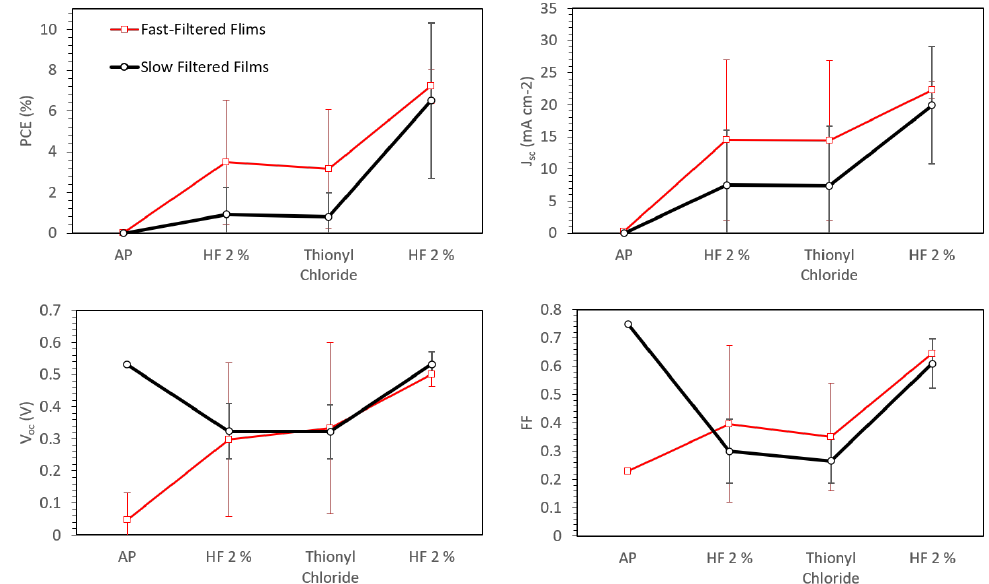
Figure 6. J / V properties for devices with 400 µ L aliquot slow and fast-filtered arc-discharge SWCNT Figure 6. J/V properties for devices with 400 µL aliquot slow and fast-filtered arc-discharge SWCNT films. Where PCE is Percent Current E ffi ciency, J sc is Short-Circuit Current Density, V oc is Open Circuit films. Where PCE is Percent Current Efficiency, J sc is Short-Circuit Current Density, V oc is Open Circuit Voltage, and FF is the Fill Factor. Voltage, and FF is the Fill Factor. Table 2. Solar device data for fast-filtered and slow-filtered films, bold text is the best-recorded result with the average and standard deviation in